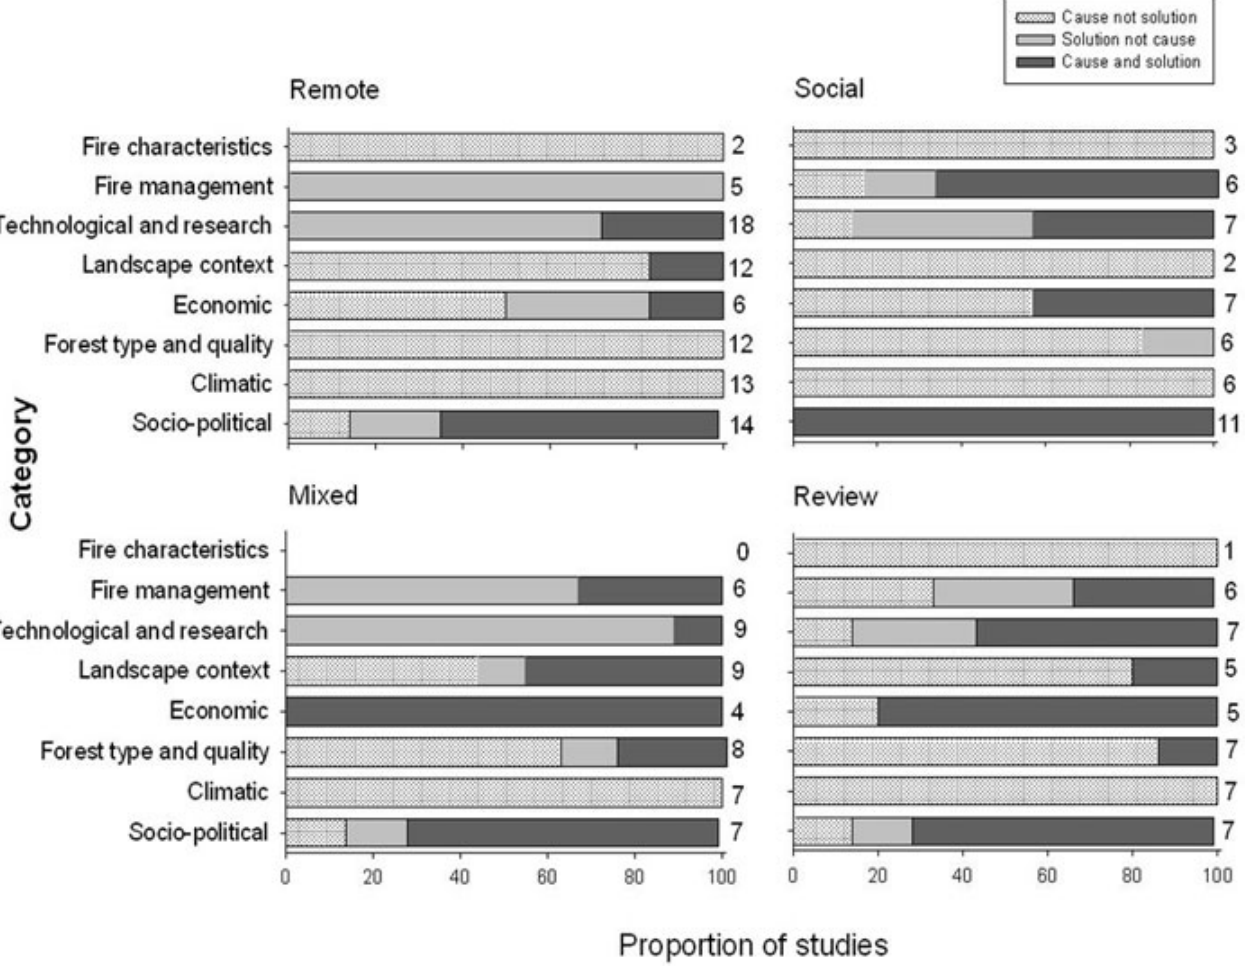
Fig. 3. Proportion of studies citing each category in relationship to a) Those that identify the category as a causal factor and not a proposed management solution; b) a management solution but not a causal factor; c) a causal factor and a proposed management solution. N studies is given on the right of each